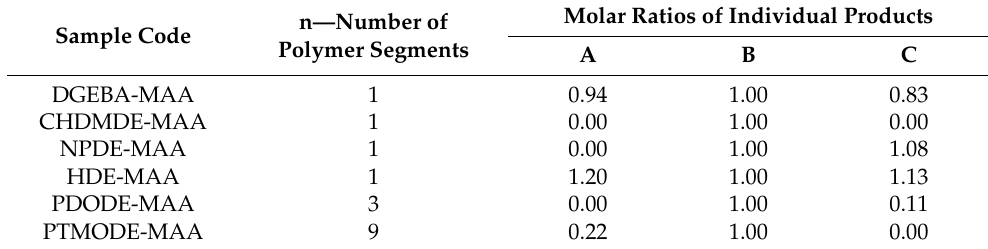
Table 2. Molar ratios of relevant epoxy methacrylate pre-polymers.